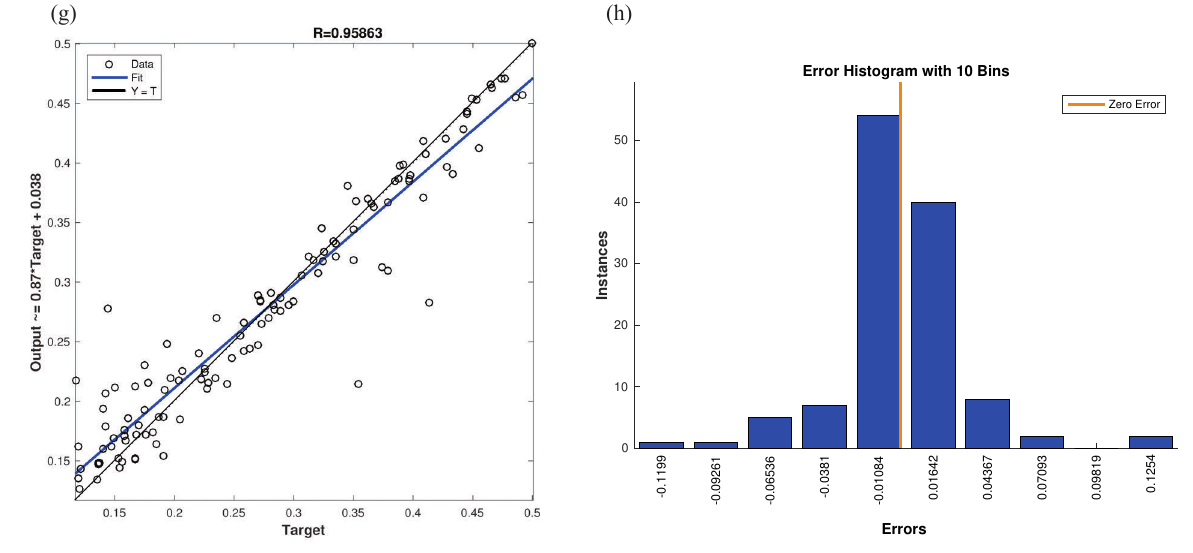
Fig. 3. Correlation and error distribution of the predicted cracks by the ensemble of the ANNs: (a)-(b) location from the left side of the beam; (c)-(d) distance between two cracks; (e)-(f) depth of the first crack; (g)-(h) depth of the second